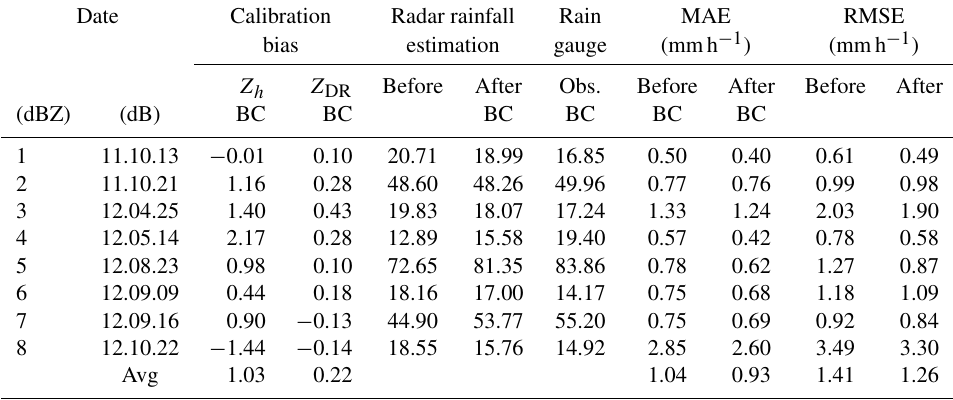
Table 5. Mean absolute error (MAE) and root-mean-square error (RMSE) of rainfall estimates before and after applying bias correction.